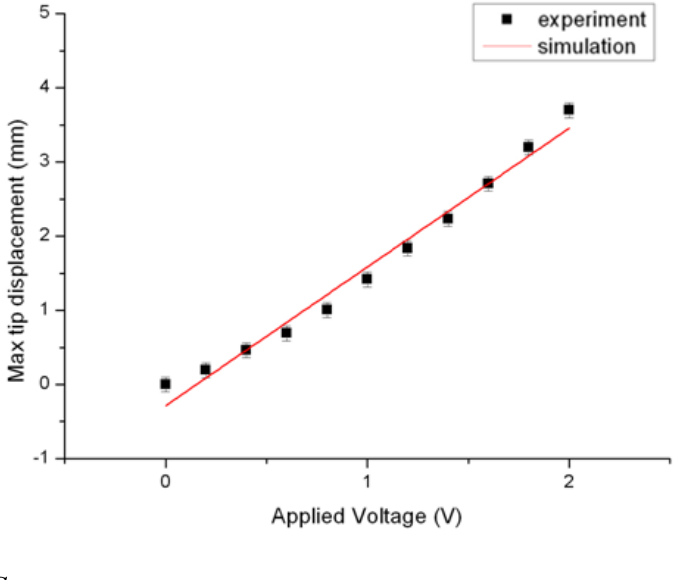
Figure 8. The agreement of experimental and simulation results for max tip displacement vs. applied